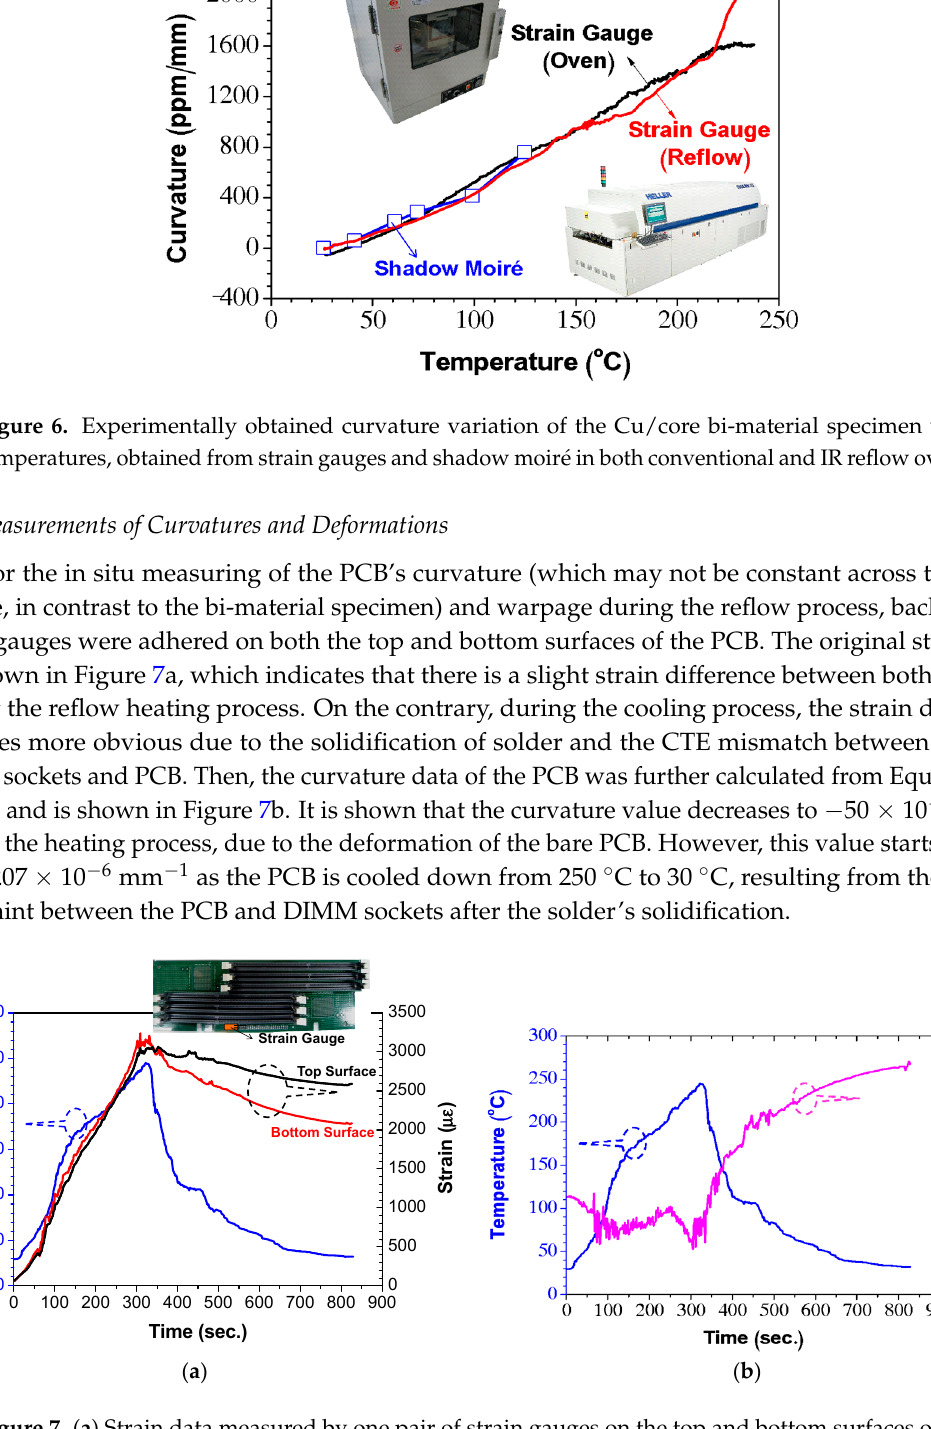
Figure 7. ( a ) Strain data measured by one pair of strain gauges on the top and bottom surfaces of the PCB and temperature profile during reflow process, and ( b ) the obtained curvature of the PCB and temperature profile with different time.